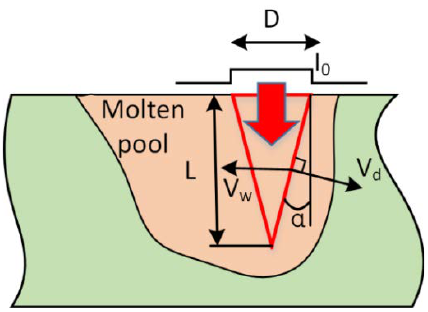
Figure 14. Schematic diagram of the molten pool along the welding direction during laser welding.